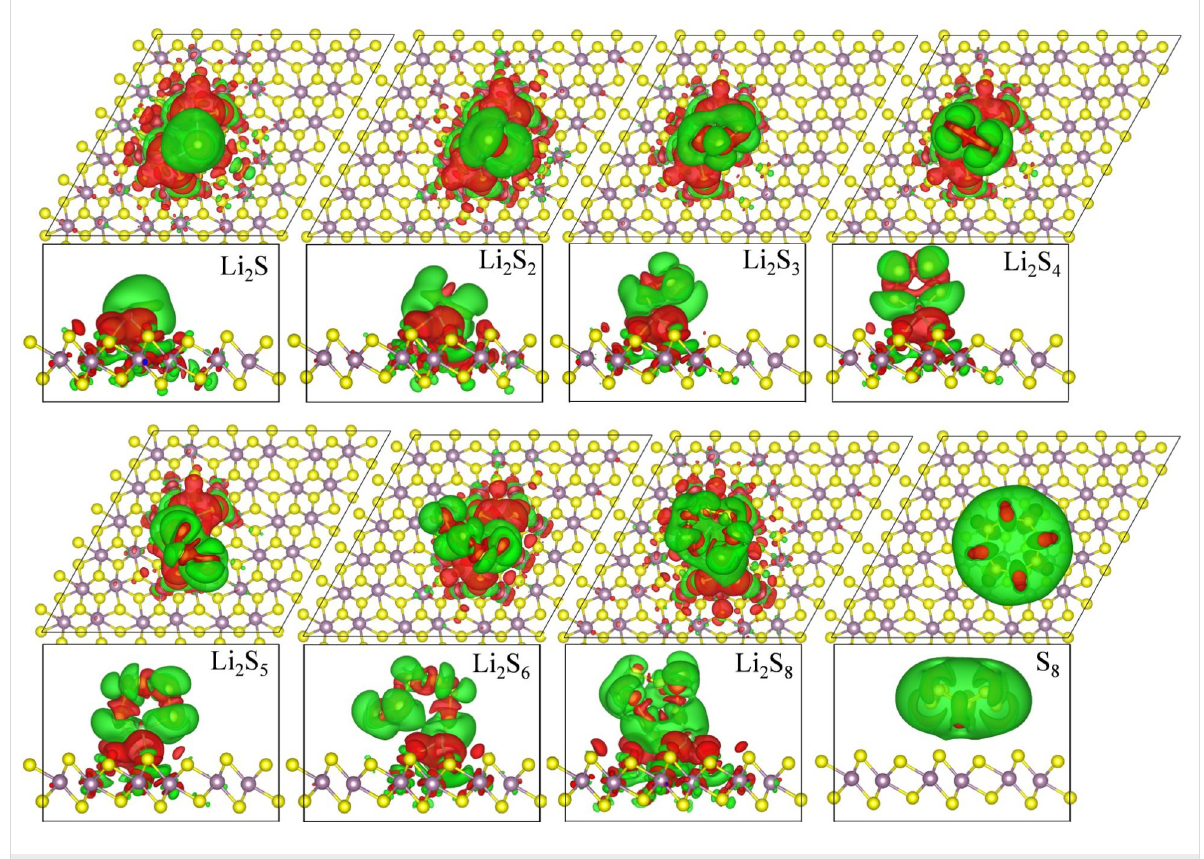
Figure 4: Isosurface (0.0005 e/Å 3 ) of the charge distributions of Li 2 S x absorbed on 1T'-MoS 2 monolayer. The red and green surfaces correspond to charge gain and loss, respectively.